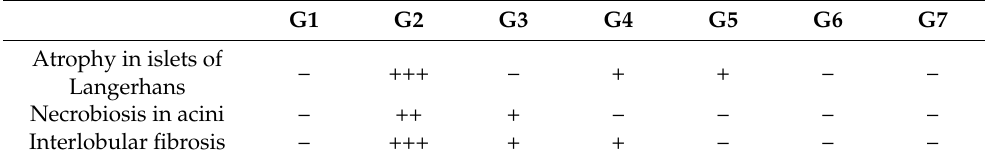
Table 8. The severity of histopathological alteration in rat pancreas underlying structure of different experimental groups treated by probiotic-enriched FCM combined with S. officinalis